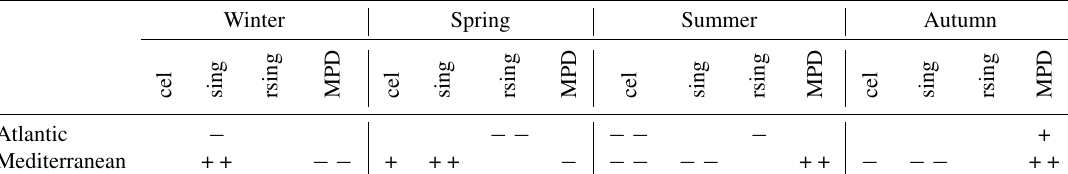
Table 2. Significant differences in descriptor distribution between the period 1985–2019 and the period 1950–1984 for Atlantic and Mediter- ranean circulations. Differences are considered significant if the p value of either the Kolmogorov–Smirnoff test or the Anderson–Darling test is lower than 5%. Differences that are significant with both tests are marked with a double sign. The sign indicates whether the average descriptor value has increased (+) or decreased ( − ) from 1950–1984 to 1985–2019. Celerity, singularity and relative singularity are denoted by cel, sing and rsing, respectively.